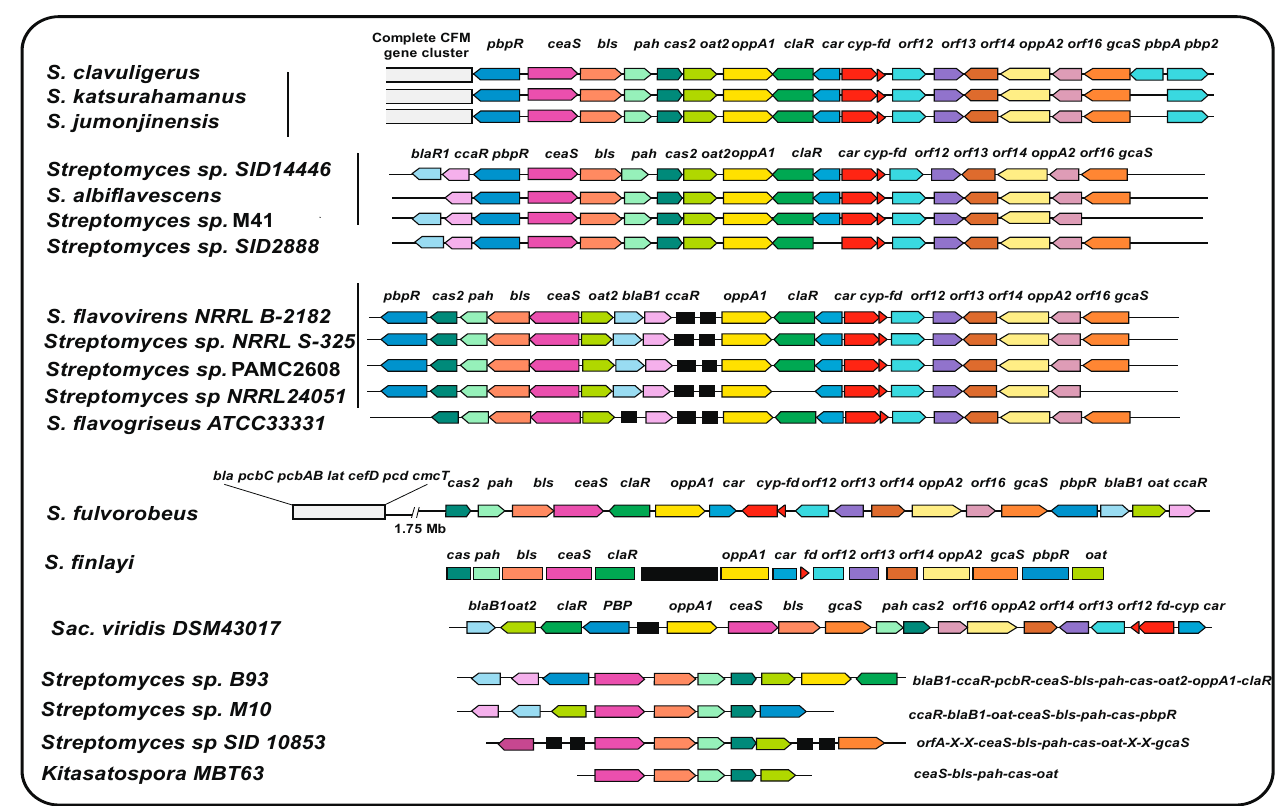
Figure 3. Organization of the clavulanic acid gene clusters of different actinobacteria. The name of the strain is indicated in the left column. The genes are color-coded and their names are indicated. Genes in black color are not related to cephamycin or clavulanic acid biosynthesis. The initial search of CA gene clusters was made using the essential S. clavuligerus proteins GcaS and CeaS2 as probes. Subsequently, all the CA biosynthesis proteins were searched using the homologous proteins of S. clavuligerus as probe. The organization of the genes was obtained using the NCBI Genome Blast tool. The gene clusters of clavulanic acid in S. clavuligerus , S. jumonjinensis-S.katsurahamanus , S. flavogriseus , and Sacc. viridis have been previously reported [45,66,76]. The CA clusters of all